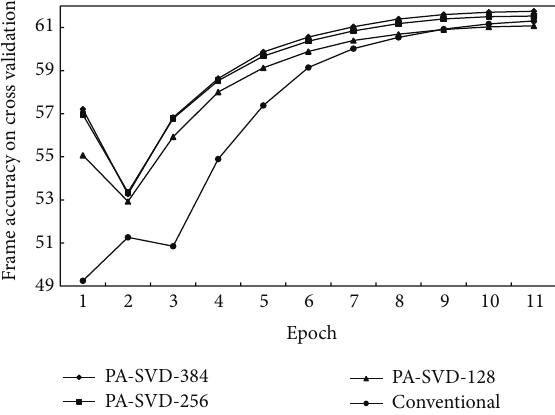
Figure 3: Frame accuracies on cross validation during the first epoch.